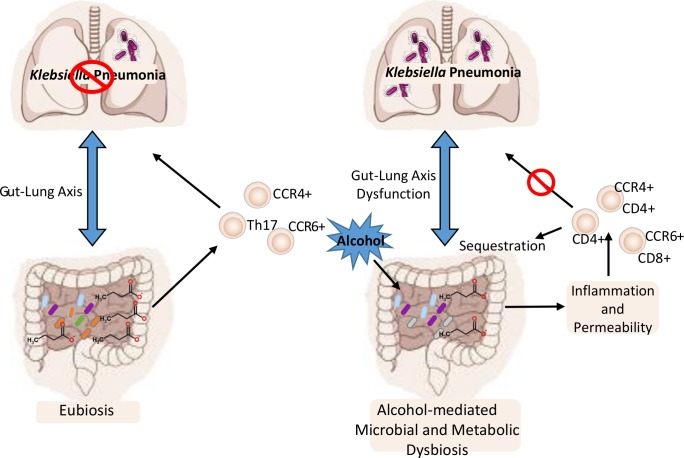
Working model for the effects of alcohol-dysbiosis on host defense against pulmonary pathogens.Alcohol promotes intestinal microbial and metabolic dysbiosis, which increases intestinal inflammation and permeability leading to intestinal T-cell sequestration and impaired T-cell trafficking to the respiratory tract, all of which, in combination, increase host susceptibility to respiratory infection with Klebseilla pneumoniae.